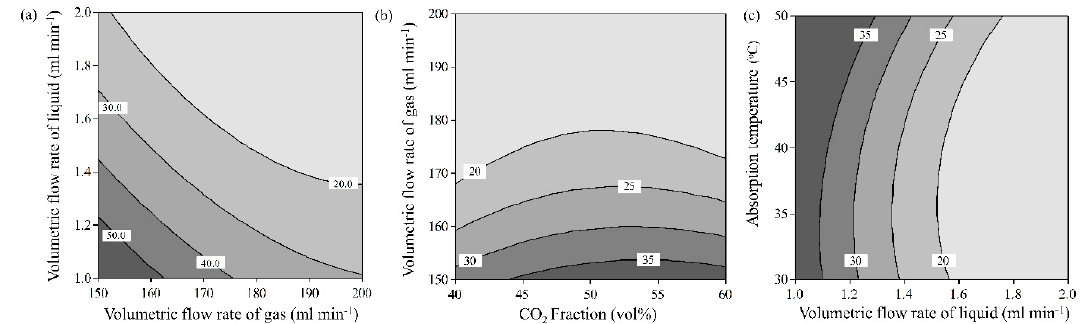
Figure 5. Interaction effect of variable pairs; ( a ) volumetric flow rate of gas and liquid, ( b ) volumetric Figure5. Interactione ff ectofvariablepairs; ( a )volumetricflowrateofgasandliquid, ( b )volumetricflow flow rate of gas and CO 2 fraction, ( c ) volumetric flow rate of liquid and temperature. rate of gas and CO 2 fraction, ( c ) volumetric flow rate of liquid and Table 2. ANOVA results for 3 k factorial design.